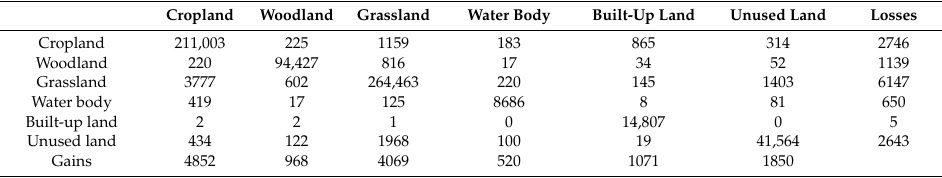
Table 1. Transition matrix of LULCC in the Loess Plateau between 1990 and 2000 (Unit: km 2 ). Cropland Woodland Grassland Water Body